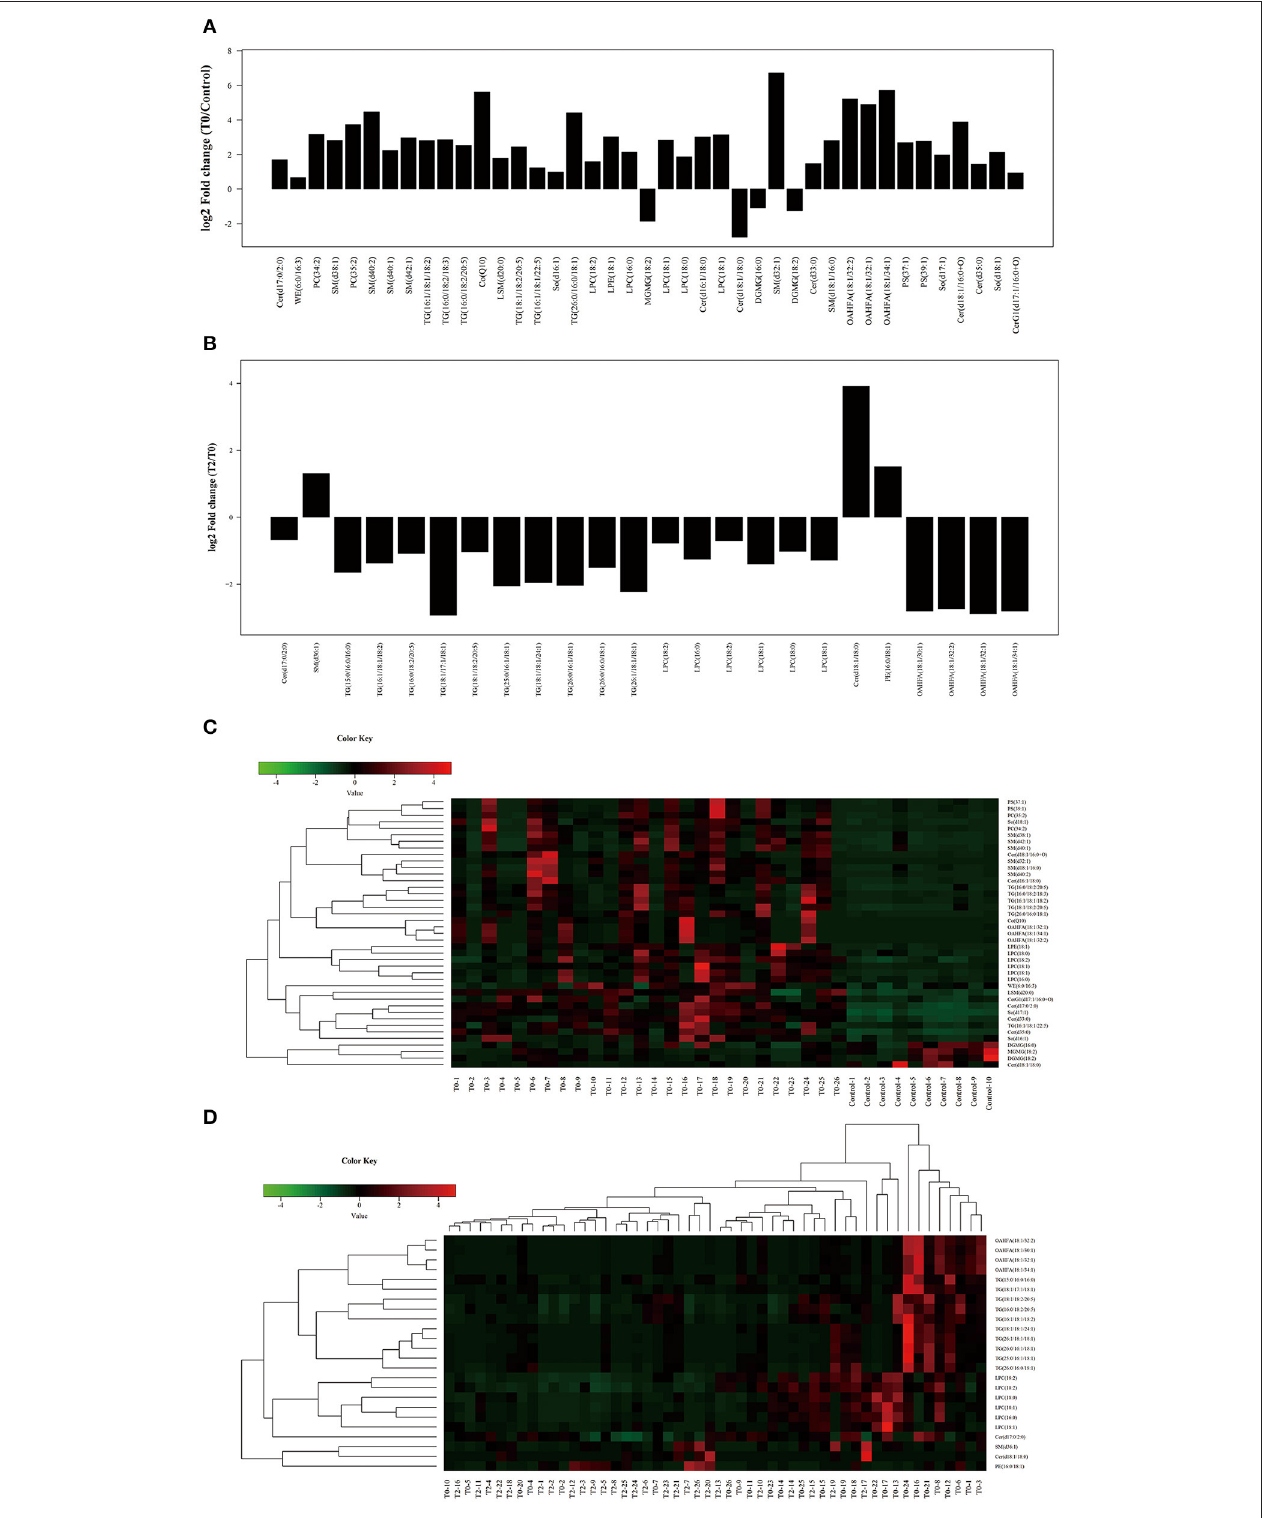
FIGURE 4 | Significant different subclasses of lipids involved in IPL treatment. The fold change (A) and heatmap (C) of T0 vs. C; the fold change (B) and heatmap (D) of T2 vs. T0. Control ( n = 10), T0 ( n = 26), T2 ( n = 26).